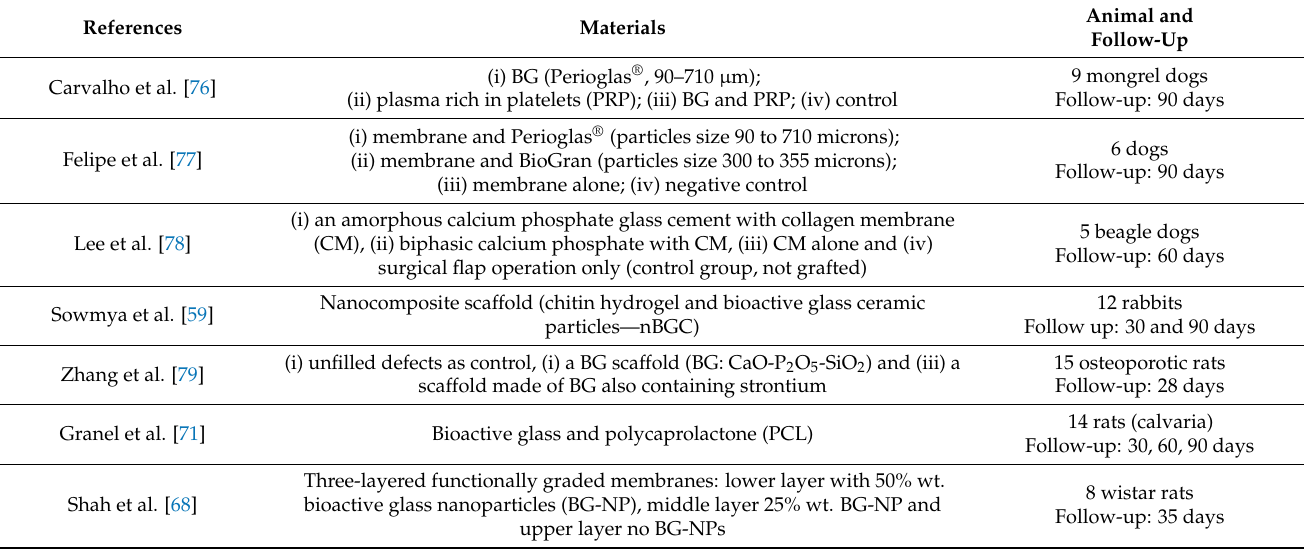
Table 2. Summary of in vivo studies (in